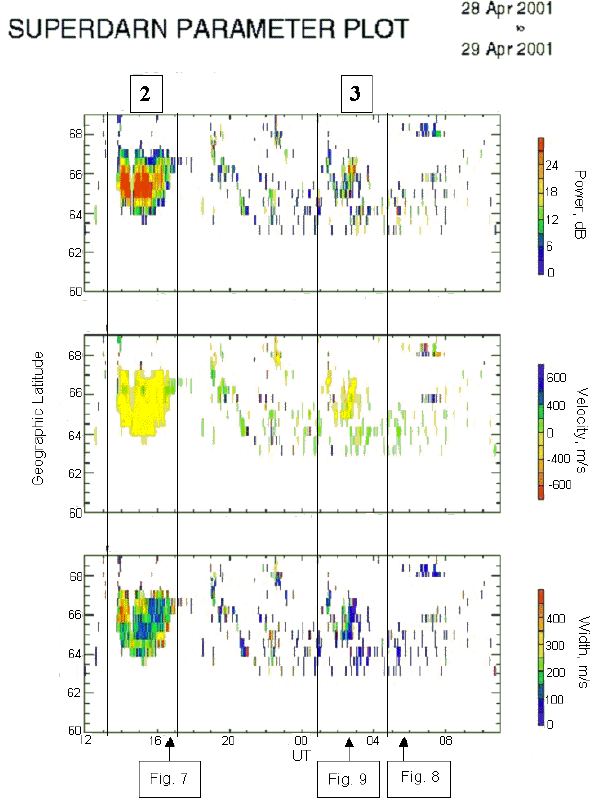
Fig. 10. Ionospheric scatter observed by CUTLASS Finland radar during a magnetic storm 28–29 April, (a) power, (b) velocity, and (c) spectral